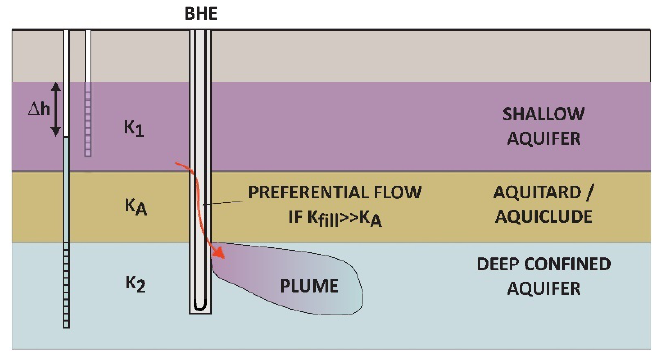
Figure 2. Possible contamination due to anti-freeze leakage from a BHE.